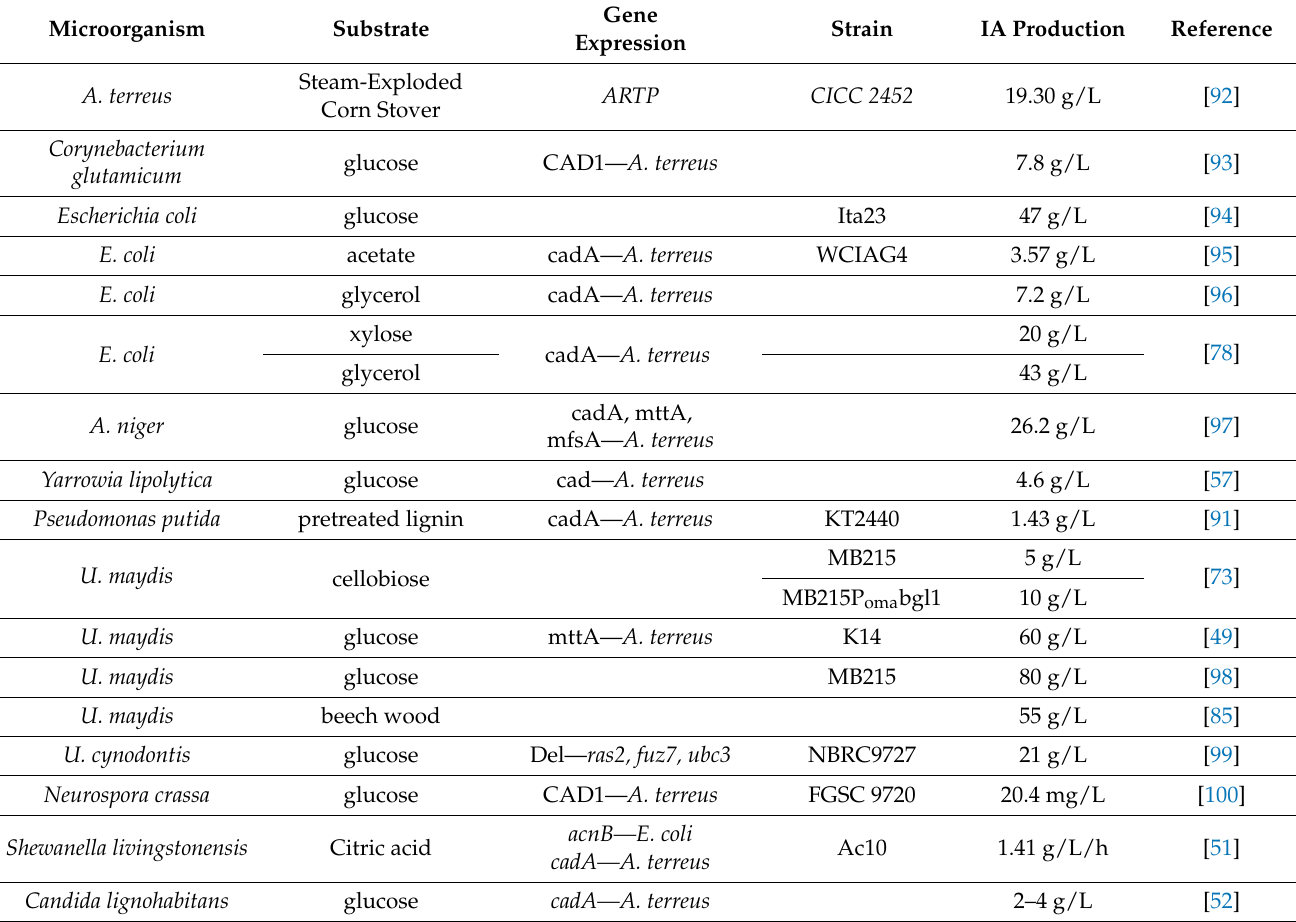
Table 3. Metabolically engineered microorganisms for IA